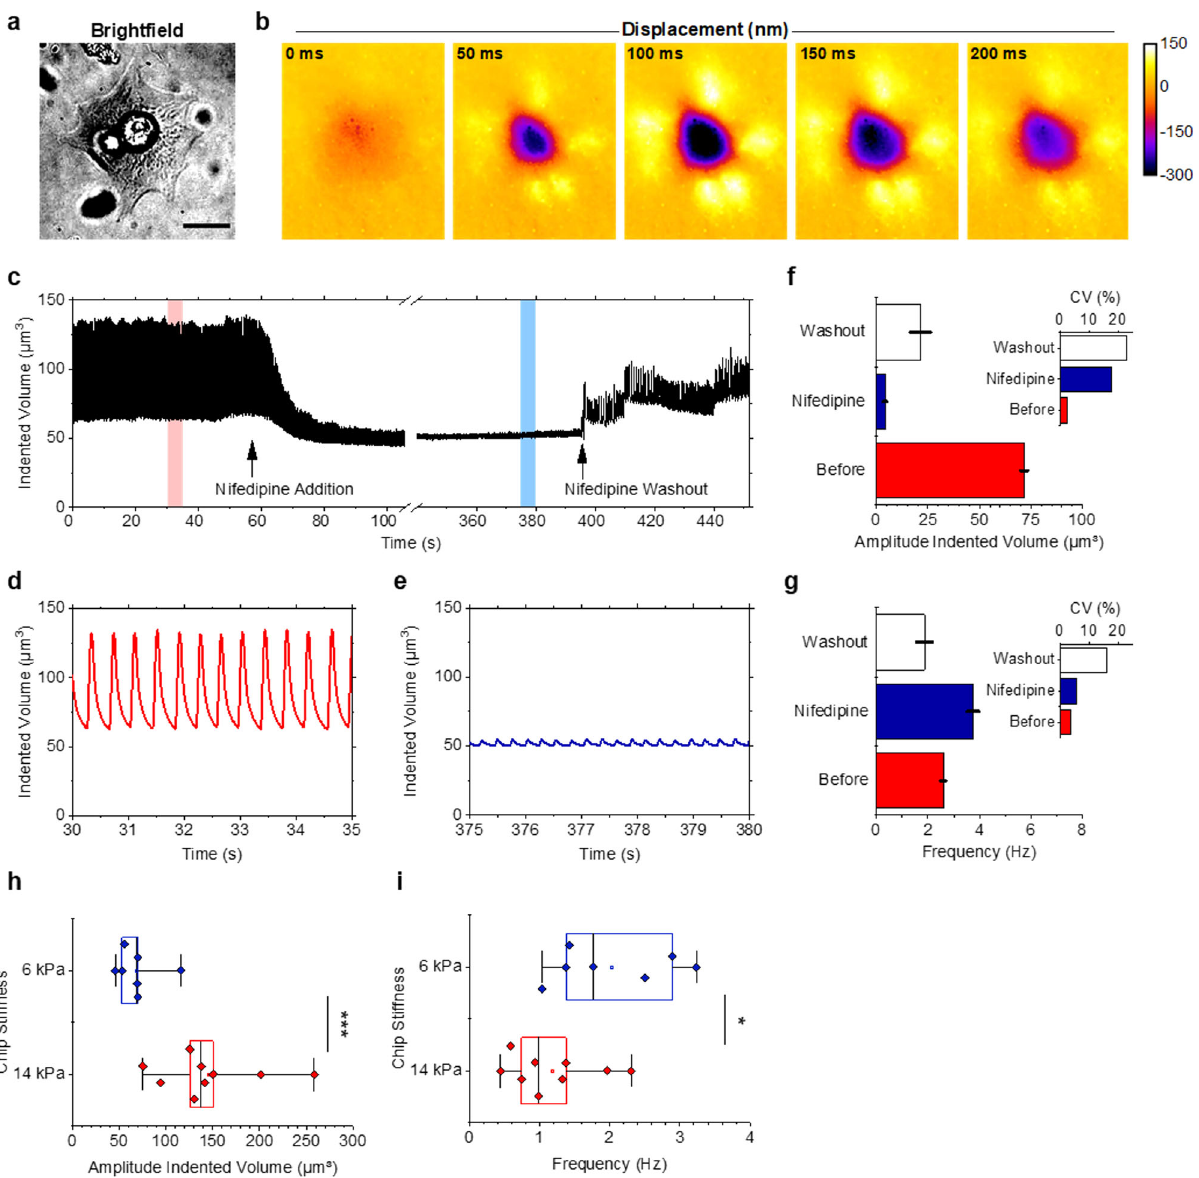
Fig. 4 High-speed contraction imaging of beating cardiomyocytes. a Bright fi eld image and b section from a 100 fps time-lapse of displacement images for a periodically contracting neonatal cardiomyocyte. c Temporal evolution of total force exerted by the cell, as quanti fi ed by the volume it indents into the microcavity chip, before, and upon administration of the calcium channel inhibitor nifedipine and following a subsequent washout. Data extracted from a 7- min time-lapse containing a total of 43,000 frames. d Data from interval marked by the red box in c on a fi ner timescale showing the periodic contractions before the addition of nifedipine. e Data from interval marked by blue box in c indicating a signi fi cant reduction in amplitude of contraction force after addition of nifedipine. f Amplitude of contraction forces over 20 s intervals before, during and after nifedipine exposure. Data shows the mean ±standard deviation (s.d.). Inset, coef fi cient of variation (CV) for each case. n = 52 contractions for before, n = 76 contractions for nifedipine, n = 36 contractions for washout. g Frequency of contraction over 20 s intervals before, during and after nifedipine exposure. Data show the mean ±s.d. Inset, CV for each case. n = 52 contractions for before, n = 76 contractions for nifedipine, n = 36 contractions for washout. h Box plot of contraction force over 20 s interval for two chips with different apparent stiffness. n = 9 cells for 14 kPa, n = 7 cells for 6 kPa. One-tailed Mann – Whitney U test, P < 0.001 (*** P = 0.00035). i Box plot of contraction frequency for data in h . n = 9 cells for 14 Pa, n = 7 cells for 6 kPa. One-tailed Mann – Whitney U test, P < 0.05 (* P = 0.013). Line, box and whiskers in h and i show median, interquartile range (i.e., difference between the 75th and 25th percentiles) and maximum/minimum data points, respectively. Scale bar, 20 μ m. Images are representative of two independent cardiomyocyte